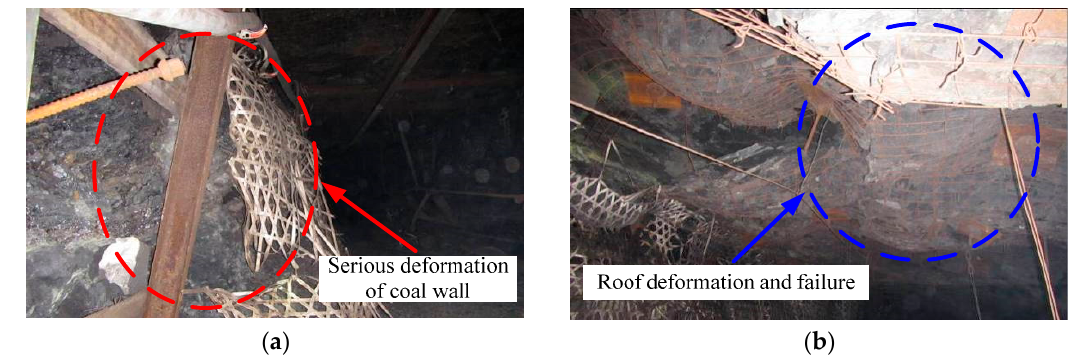
Figure 3. Surrounding rock deformation and failure in No. 2415 headentry. ( a ) Coal wall deformation; ( b ) Roof deformation.